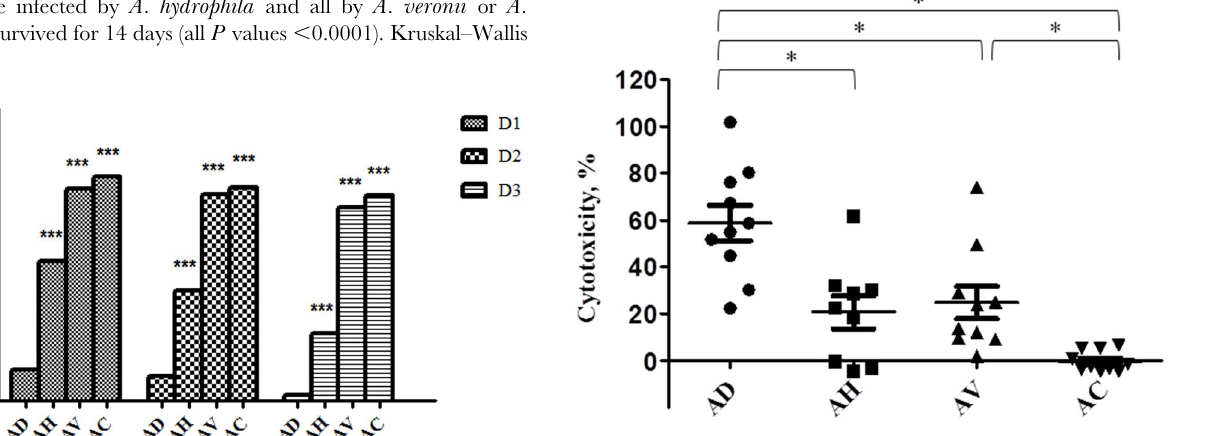
Figure 2. Cytotoxicity of Aeromonas dhakensis (AD, n=9), A. hydrophila (AH, n=9), A.veronii (AV, n=9) and A.caviae (AC, n=9) isolates to C2C12 mouse fibroblast cell lines, which is expressed as the proportions of the released LDH levels induced by Aeromonas isolates, as compared with the LDH level by 0.1% Triton X-100 (a positive control: 100%). * P , 0.05.